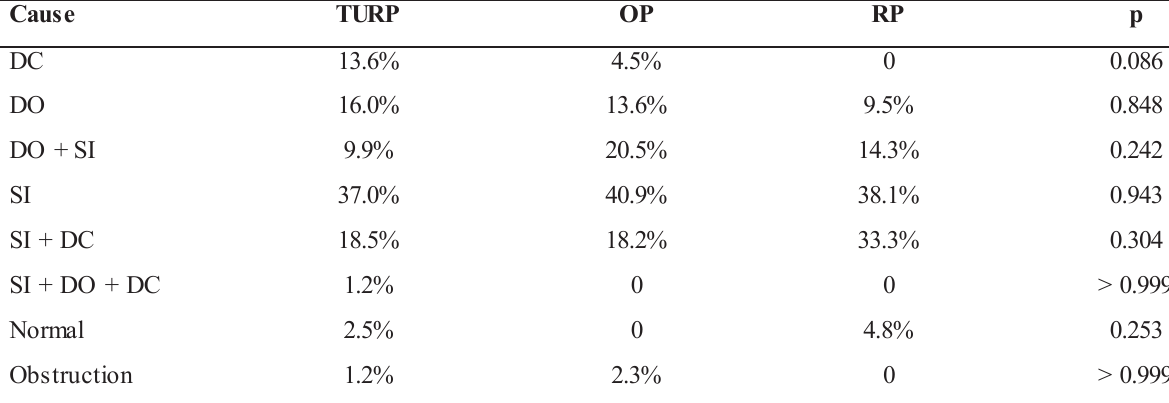
Table 2 - Cause of UI according to the type of surgery.